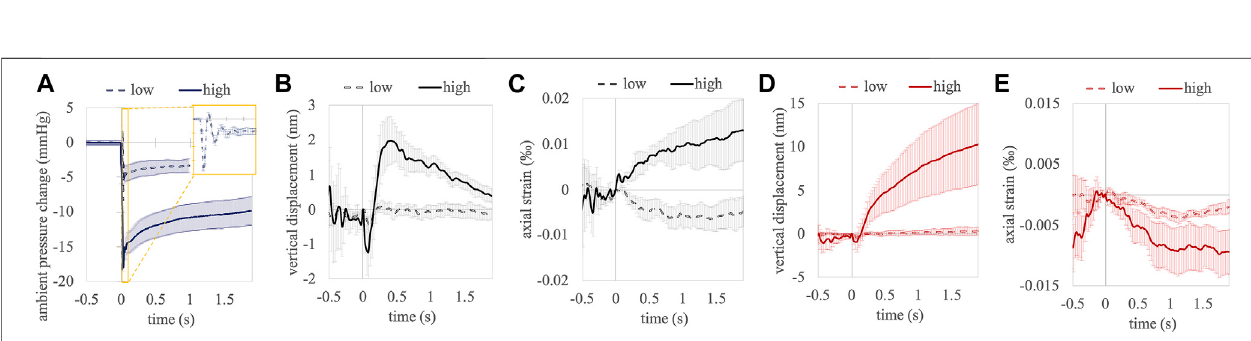
FIGURE 3 | Temporal evolution of ambient pressure (A) , accumulated vertical displacement (B) and accumulated axial strain (C) between subsequent A-scans in the central cornea. Accumulated vertical displacement (D) and accumulated axial strain (E) in the anterior crystalline lens. Error bars represent standard error.